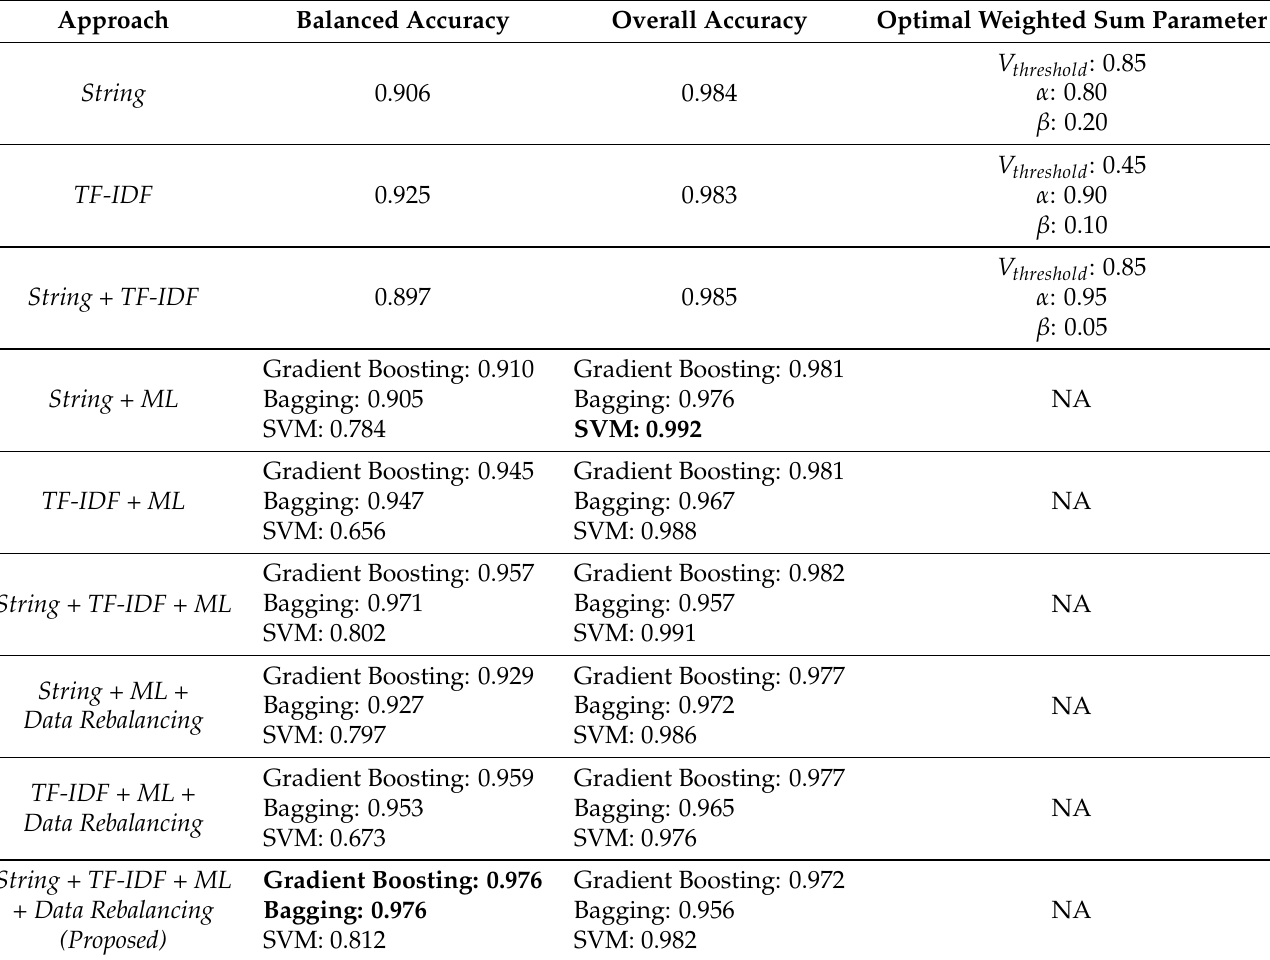
Table 5. POI matching accuracy of the proposed approach (i.e., String + TF-IDF + ML + Data Rebalancing ), compared against other baseline approaches. Approaches using a machine learning model to perform POI matching do not need to define weighted sum parameters as it will be learned by the